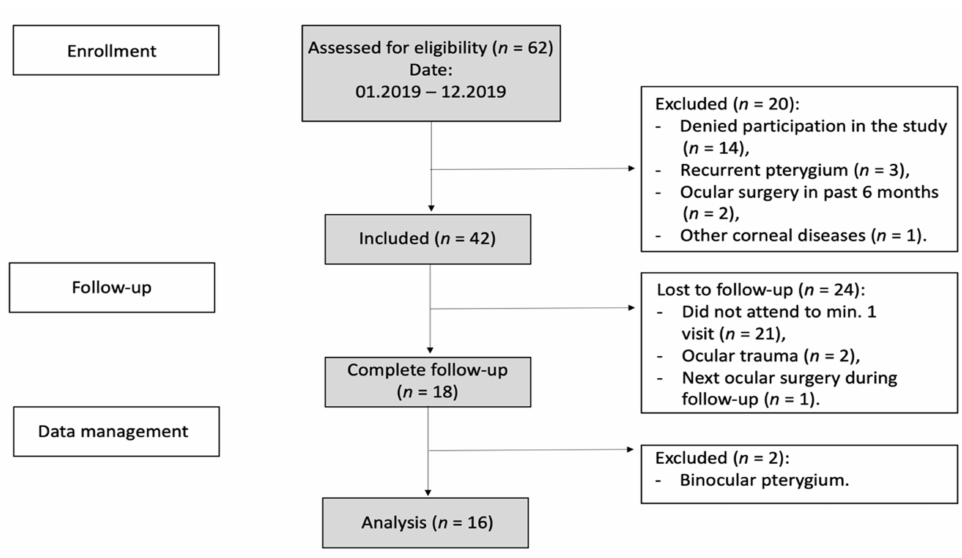
Figure 1. Flowchart of the